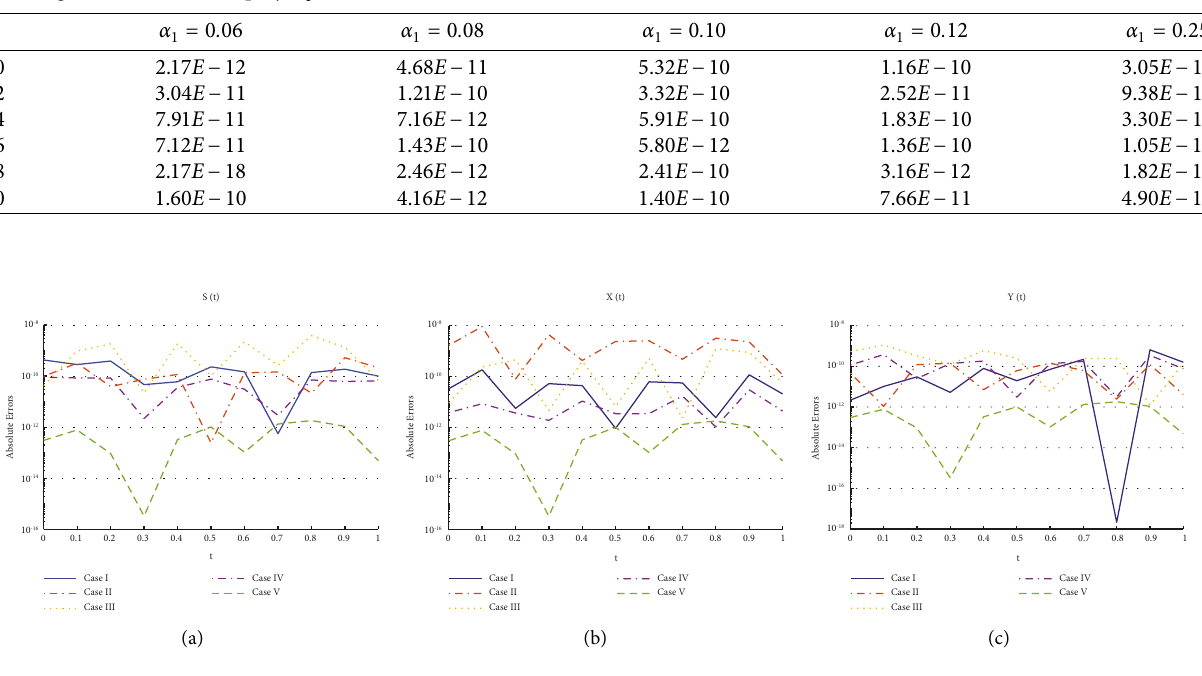
Figure 4: Absolute errors obtained by the LeNN-WOA-NM algorithm under the influence of variations in the intrinsic growth rate of local prey on population densities of the prey-predator model. (a) Population density of local prey. (b) Population density of immigrant prey. (c) Population density of the predator.